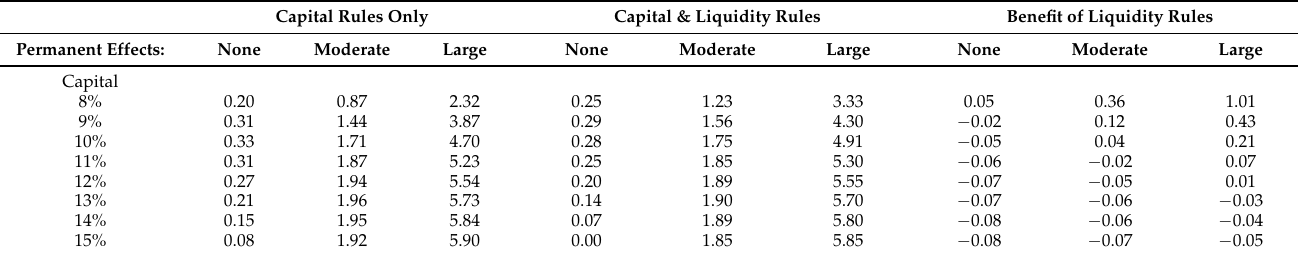
Table 3. Benefits of liquidity requirements at different levels of bank capital.